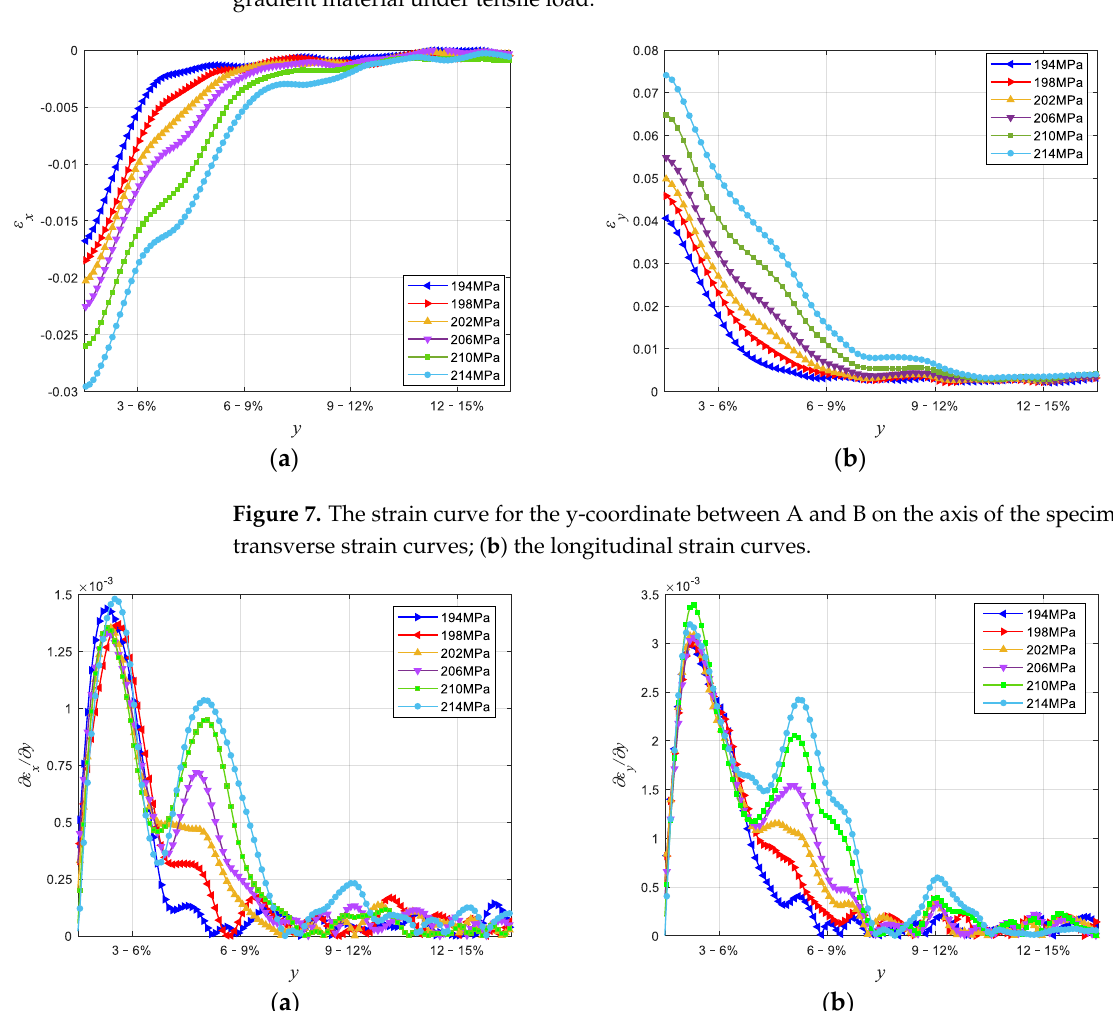
Figure 6. Force – displacement curve between point A and B of Cu/WC P laminated functionally gradient material under tensile load.